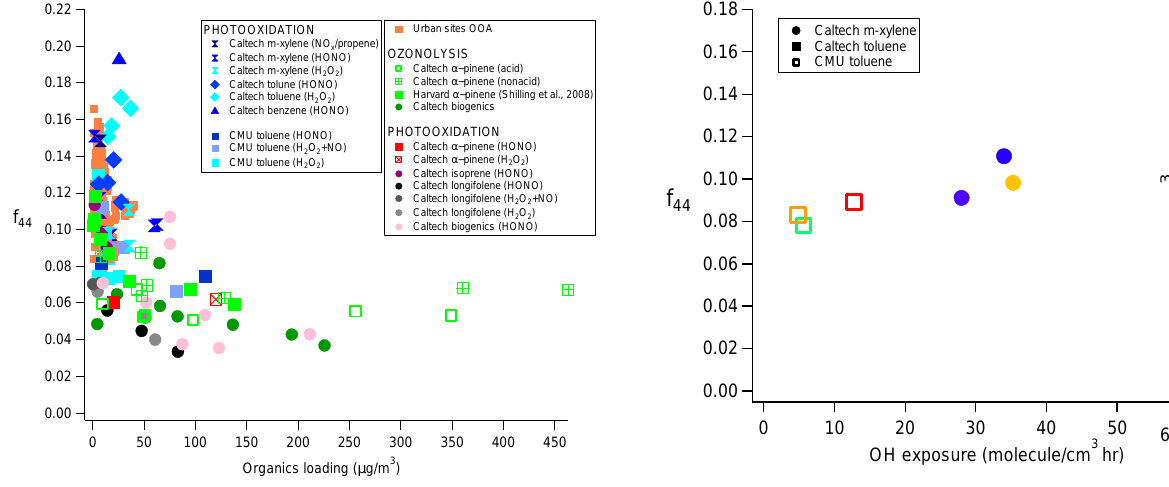
Fig. 7. f 44 as a function of organics loading (measured with AMS) for the chamber experiments shown in Figs. 6a and b. For each ex- periment, only the highest f 44 value is shown to avoid crowding the plot. The orange points are the OOA data from various urban sites (Beijing, Tokyo summer, NYC summer, Riverside, Pittsburgh).